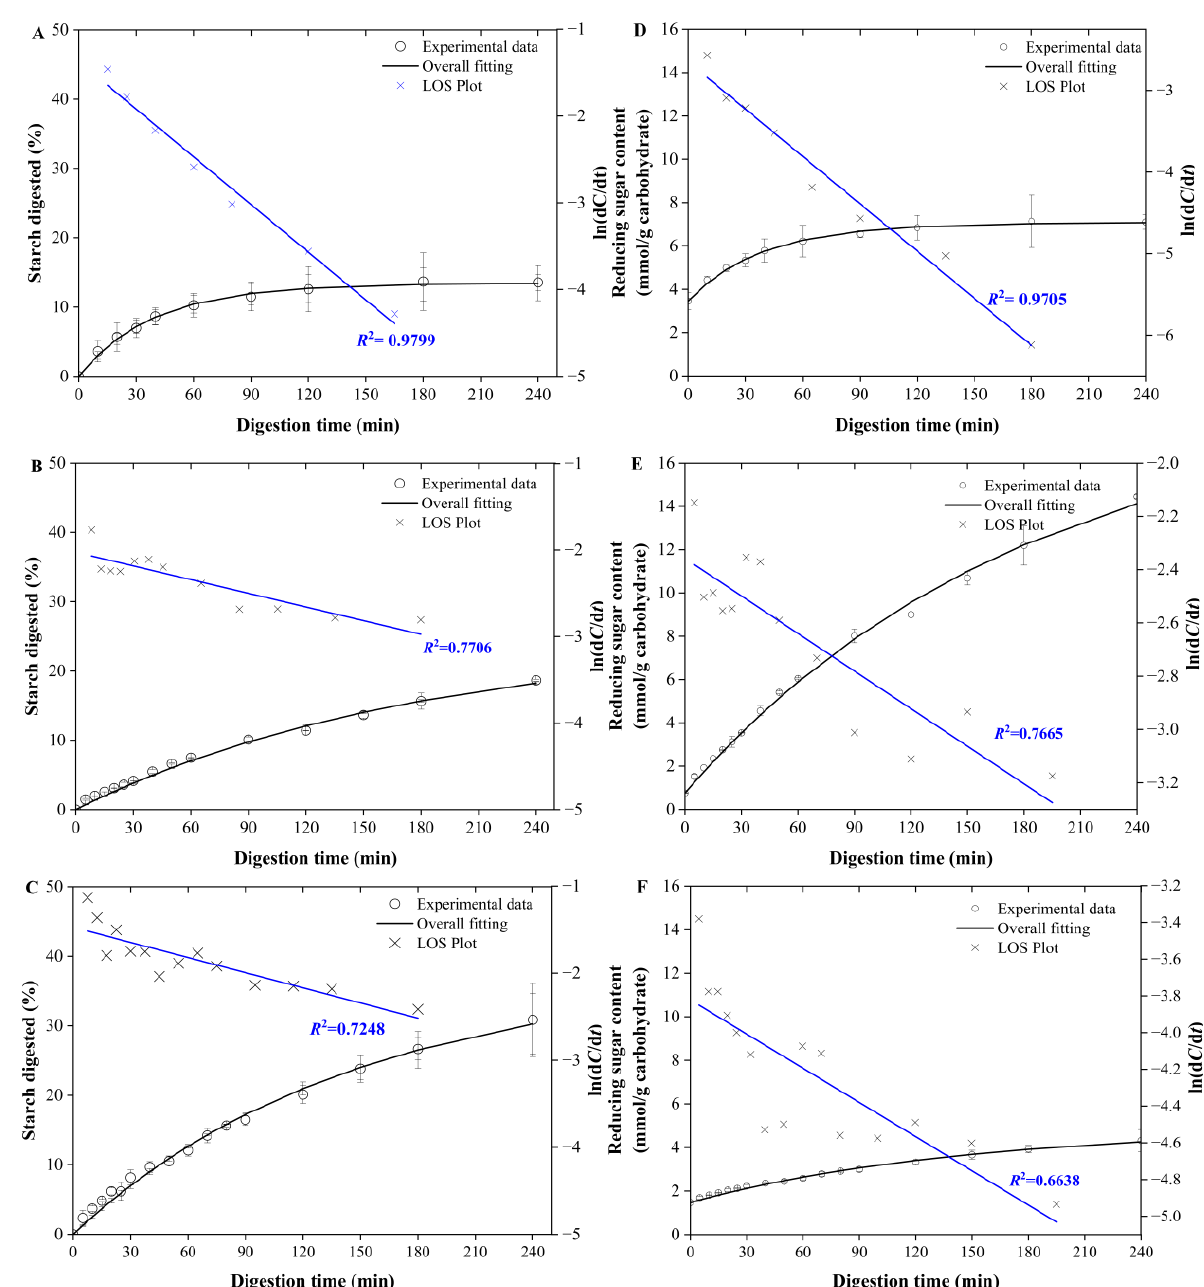
Figure 2. LOS plot for Sample 1 when digested using the INFOGEST protocol ( A ) and the single- enzyme digestion model using porcine pancreatin ( B ) or pure α -amylase ( C ), showing only one digestion phase. The left pane ( A – C ) contains the fitting results in terms of the digestion results of starch digested (%) as a function of the digestion time (min), while the right pane ( D – F ) contains the fitting results in terms of the digestion results of the total amount of released reducing-sugar content (mmol) normalized to the total carbohydrates as a function of the digestion time (min). Detailed sample information of all other samples is shown in Figure S1.